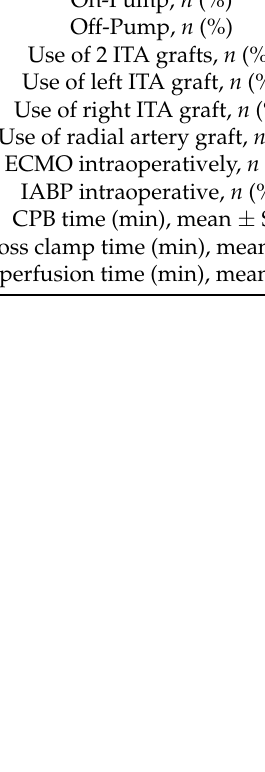
Table 3. Postoperative data ( n = 1346 before PSM and n = 744 after PSM). Before